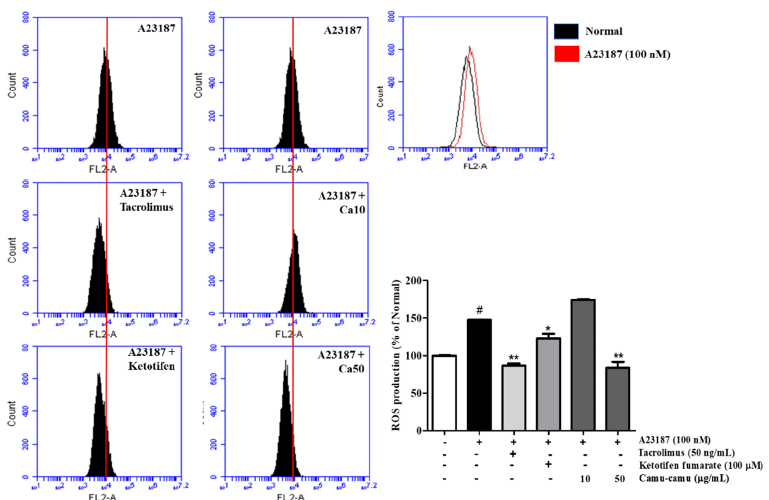
Figure 3. Effect of camu-camu fruit extract on intracellular ROS production in A23187-induced RBL-2H3 cells. Levels of intracellular ROS production were measured by flow cytometry. All data are displayed as mean ± SD of three independent experiments ( # p < 0.05 vs. the control group, * p < 0.05 and ** p < 0.01 vs. the A23187-treated group).